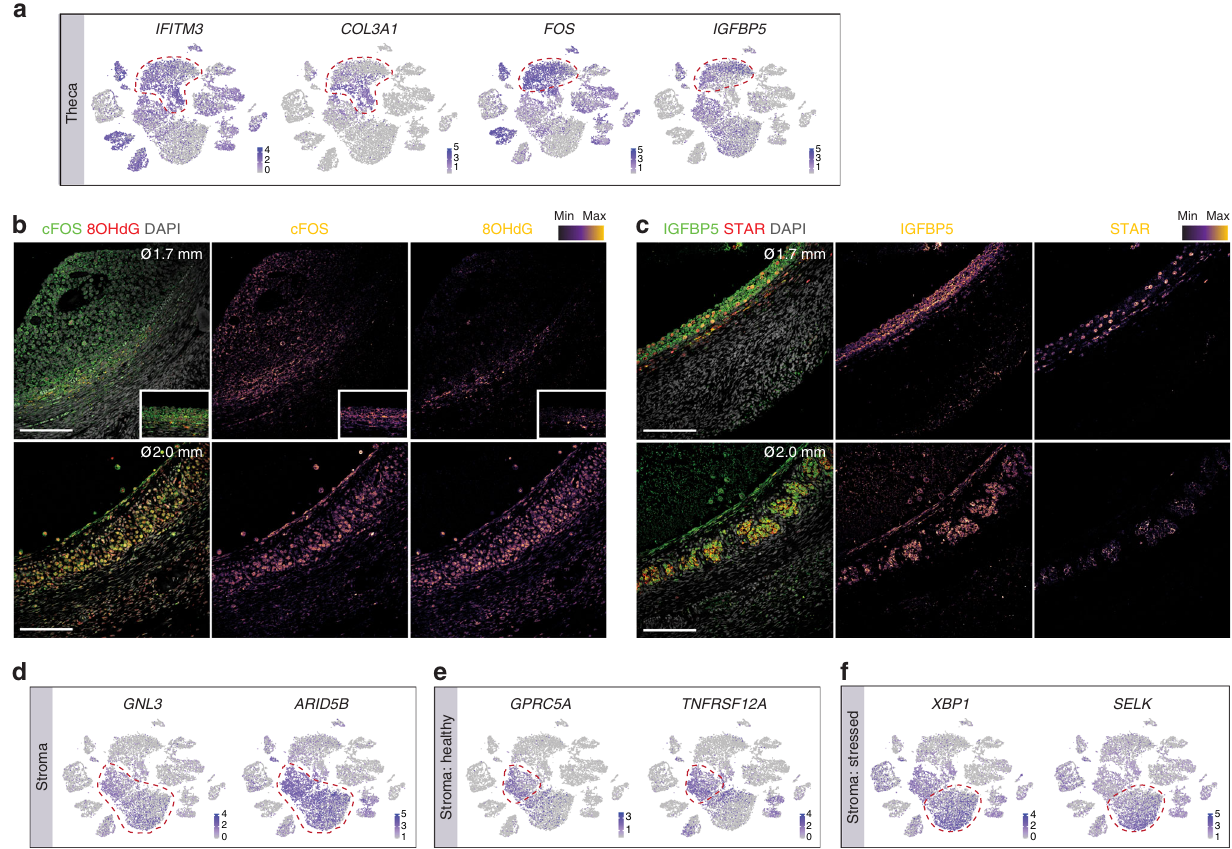
Fig. 8 Characteristics of theca and stromal cells. a tSNE cluster map showing expression of selected marker genes healthy and atretic theca cells (TC). Red dashed lines give the boundaries of the TC-clusters of interest. b , c Immunostaining of follicles (ø, diameter) growing (top row) and atretic (bottom row) for cFOS and 8OHdG ( b ) and for IGFBP5 and STAR c . Inset shows mural GC and TC of the same follicle with same magni fi cation. Single channel images were converted to an intensity map. Scale bars are 100 μ m. d , f tSNE cluster map showing expression of selected marker genes in the ovarian stroma d , healthy stroma e and stressed stroma ( f ). Red dashed lines give the boundaries of the stromal clusters of